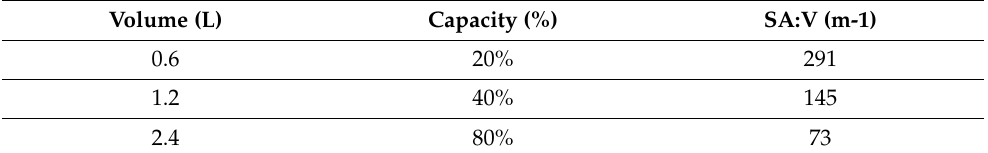
Table 3. The SA:V ratios that correspond to particular sample sizes analyzed in Mochalski et al. study. Volume (L) Capacity (%) SA:V (m-1) 0.6 20% 291 1.2 40% 145 2.4 80%